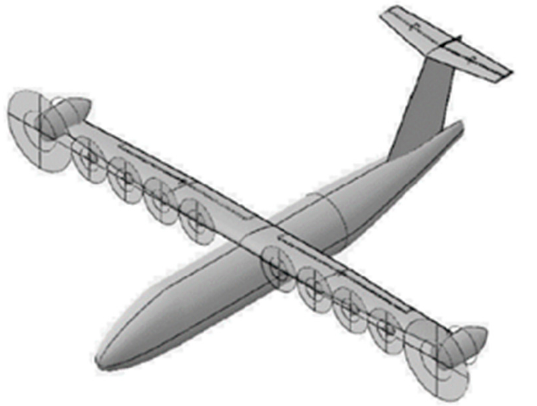
Figure 4. Configuration A.